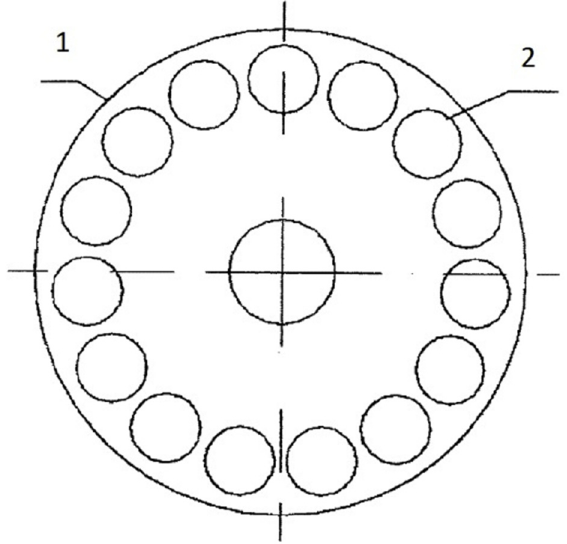
Figure 1. Impeller of the cavitation inducer used in the study (1); openings in the impeller, so-called active spaces (2).